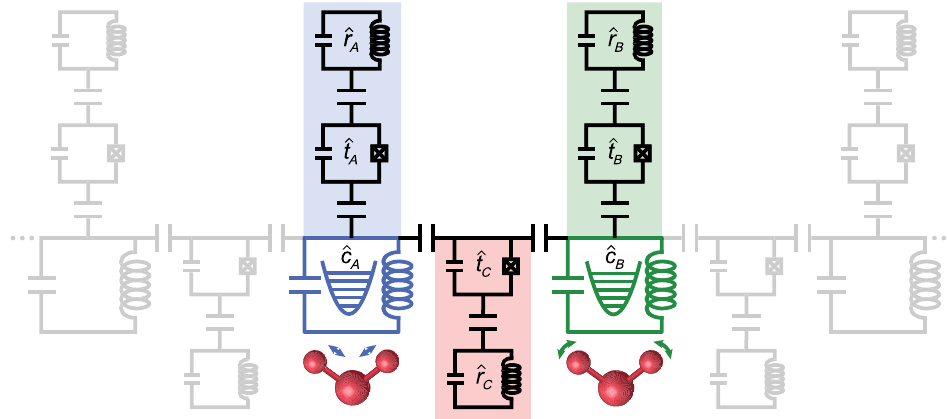
FIG. 1. Circuit schematic of the superconducting bosonic processor. The device consists of two microwave cavity modes (blue ˆ c green ˆ c ) which represent the symmetric-stretching and bending modes of a triatomic molecule in the C 2 B Ancilla measurement and control modules (shaded in blue and green) consisting of a transmon qubit ð ˆ t ð ˆ r A ; ˆ r B Þ couple to each cavity mode for state preparation and measurement. The coupler module (shaded in red) consists of a coupler and readout resonator ˆ r . The coupler transmon is used to facilitate bilinear Gaussian operations on the two cavity modes transmon ˆ t C C through four-wave mixing, and the readout resonator is used for both characterization and postselection. This configuration is extensible to a general linear array of N cavity modes with nearest-neighbor coupler modules and N ancillary modules, as depicted in light